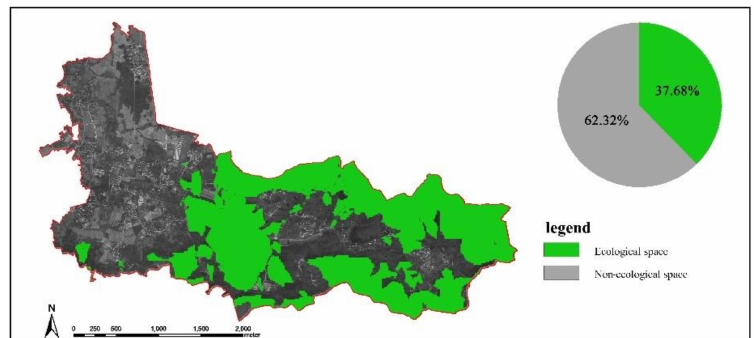
Figure 9. Ecological space in 2020.